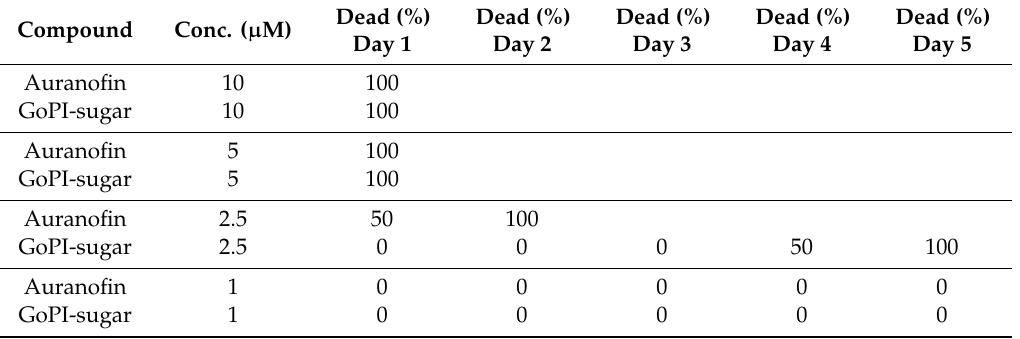
Table 2. Comparison of the worm killing activity of auranofin and GoPI-sugar against S . mansoni using a phenotypic assay [54] in adult ex vivo S . mansoni worms.